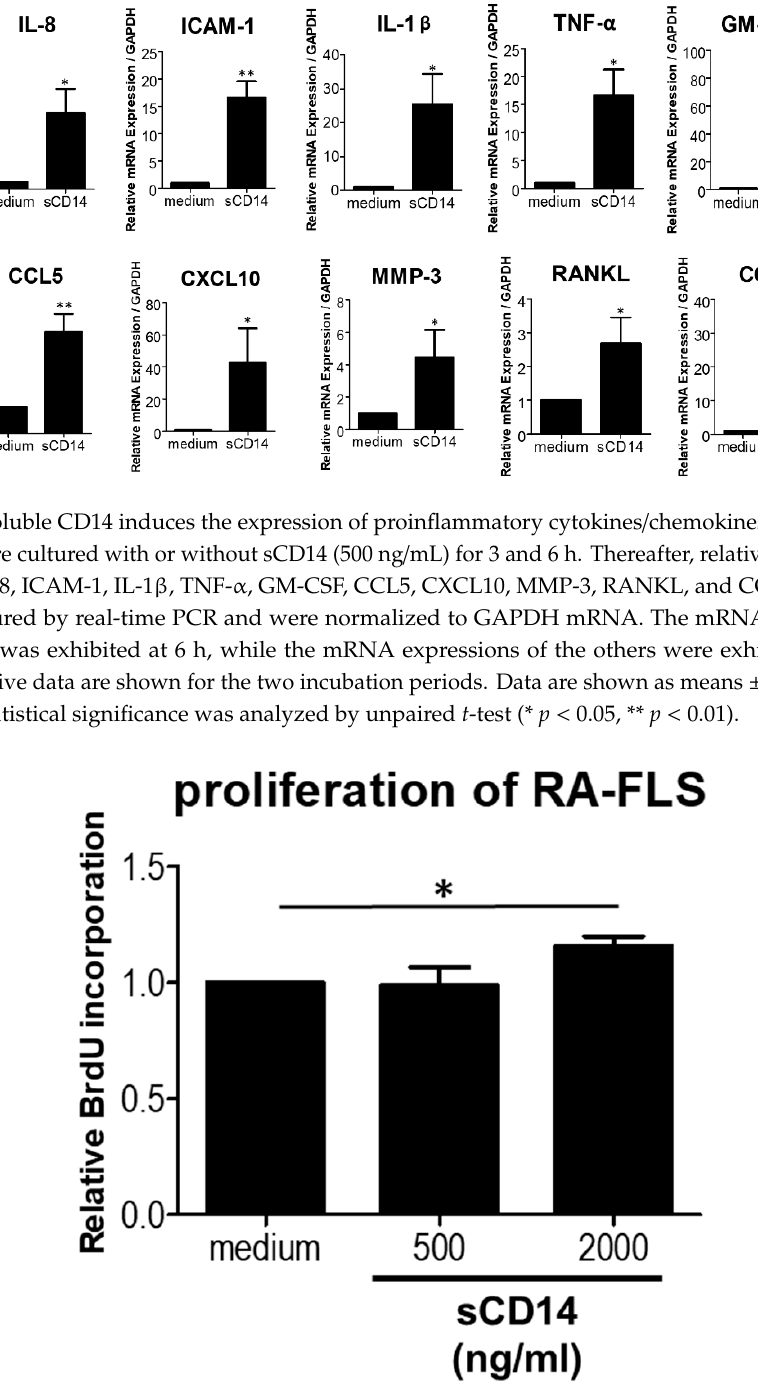
Figure 3. High concentrations of sCD14 induce the proliferation of RA-FLS. RA-FLS were cultured with or without sCD14 (500 or 2000 ng / mL) for 24 h. Cell proliferation was determined by using the BrdU assay. Each experiment was performed in quintuplicate. Data are shown as means ± SEM in three RA-FLS. Statistical significance was analyzed by Tukey’s Multiple Comparison Test (* p < 0.05).